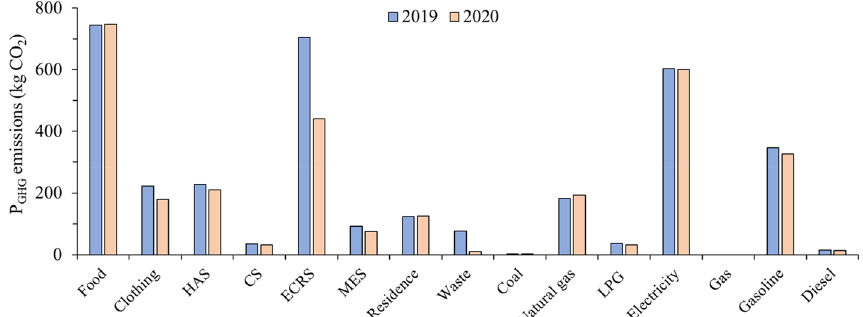
Fig. 6 The comparison of Shanghainese average P GHG emissions before and after COVID-19 Pandemic. (HAS: Household facilities, articles and services; CS: Communication services; ECRS: Education, cultural and recreation services; MES: Medicine and medical